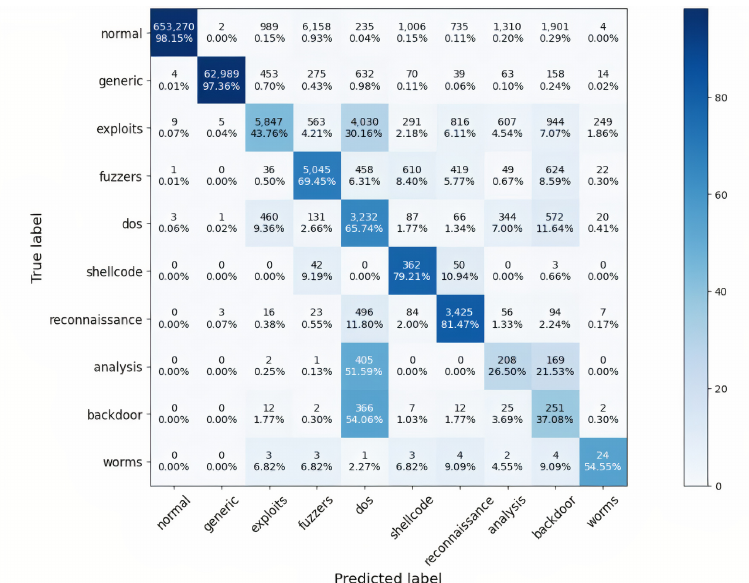
Figure 6. The attack detection model’s confusion matrix after training with synthetic samples of backdoors